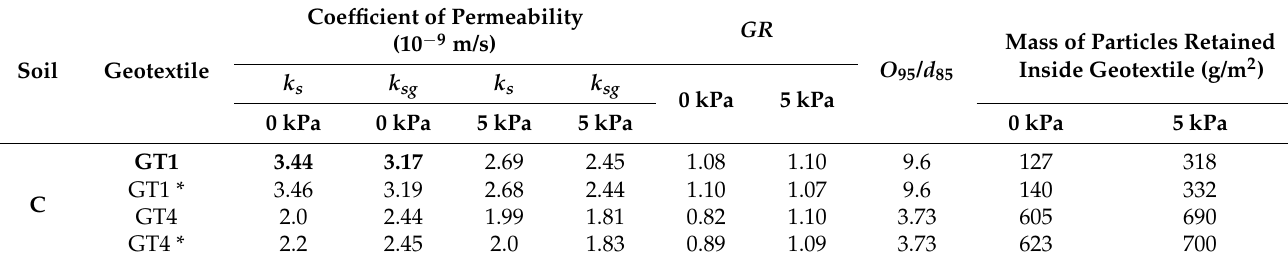
Table 6. Gradient ratio filtration test results of silty clay ( i =